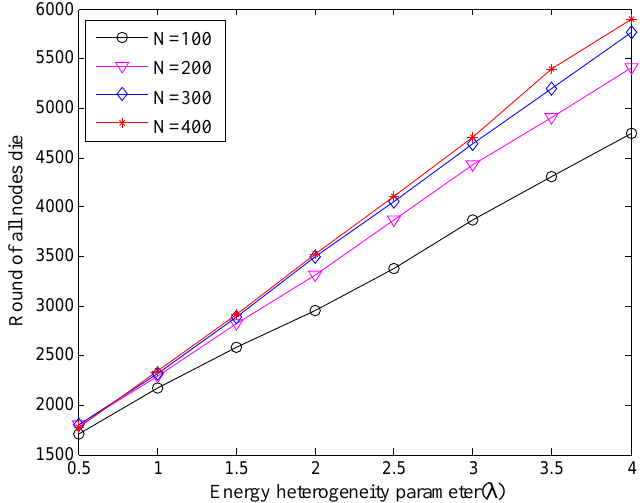
Figure 4. The whole lifetime with different number of nodes under different energy heterogeneity